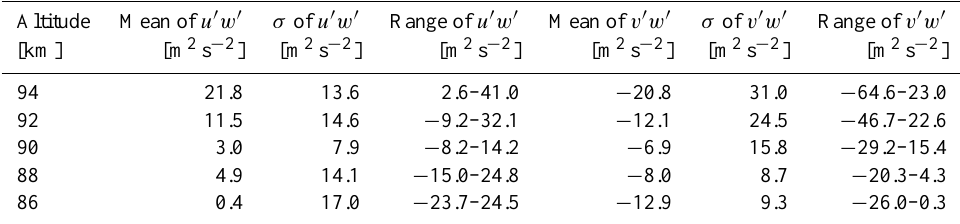
Table 1. Mean value, standard deviation ( σ) , and variation range of u (cid:48) w (cid:48) and v (cid:48) w (cid:48) at the height range of 86–94km at Koto Tabang.